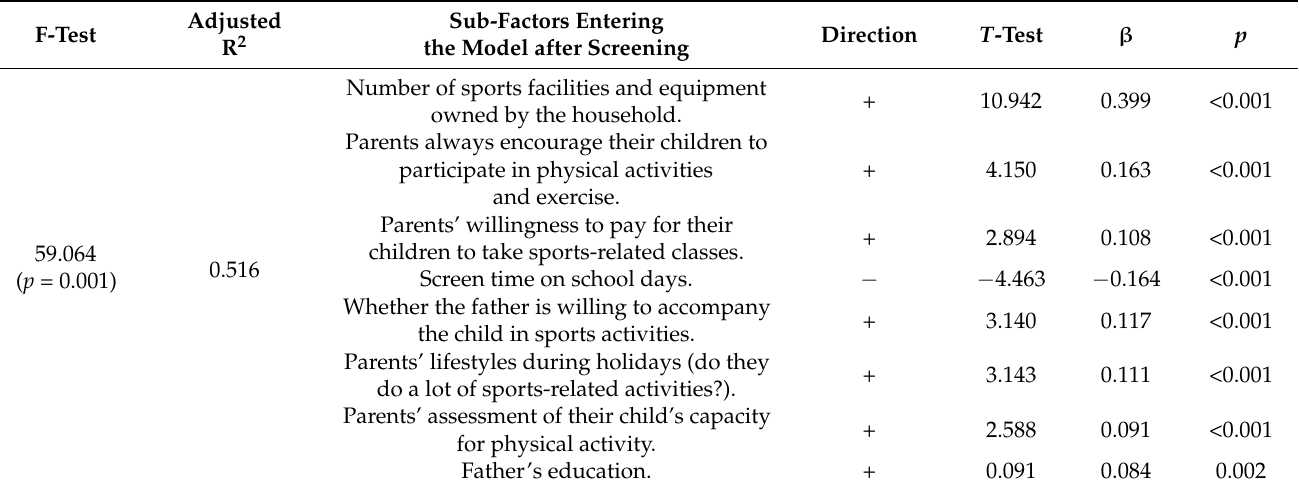
Table 6. Table of multiple regression models for the effect of home environment subfactors on school children’s scientific fitness literacy.